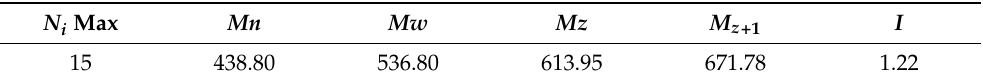
Table 1. Molecular weight average values (in Da) and polydispersity index ( I ) of the main biopoly- meric component of powdered mucilage extracted from peels of OFI fruits. N i Max Mn Mw